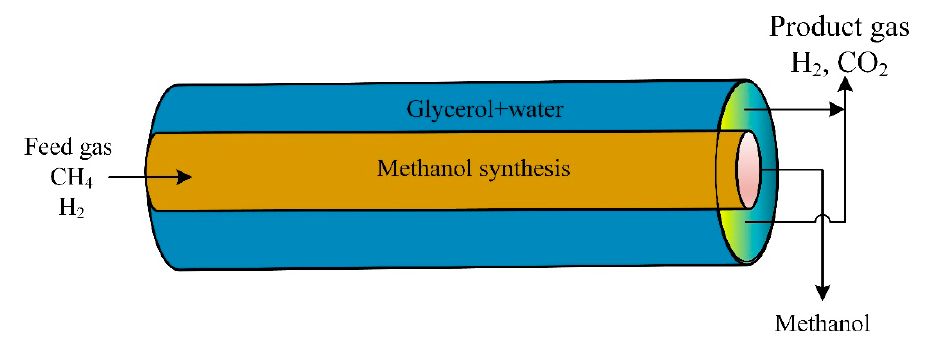
Figure 8. Schematic diagram of thermally double-coupled reactor